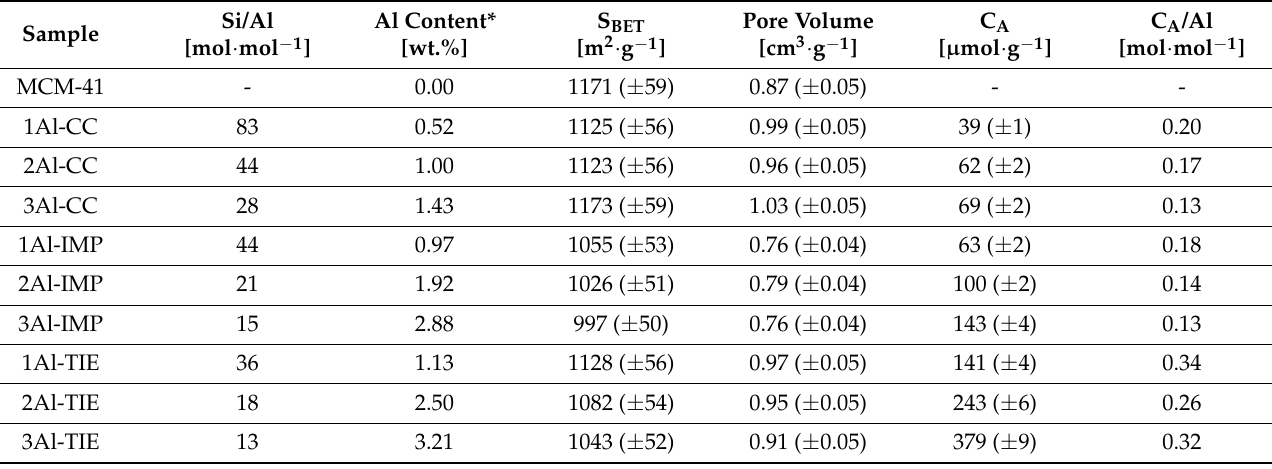
Table 1. Chemical composition, textural parameters, and surface concentration of acid